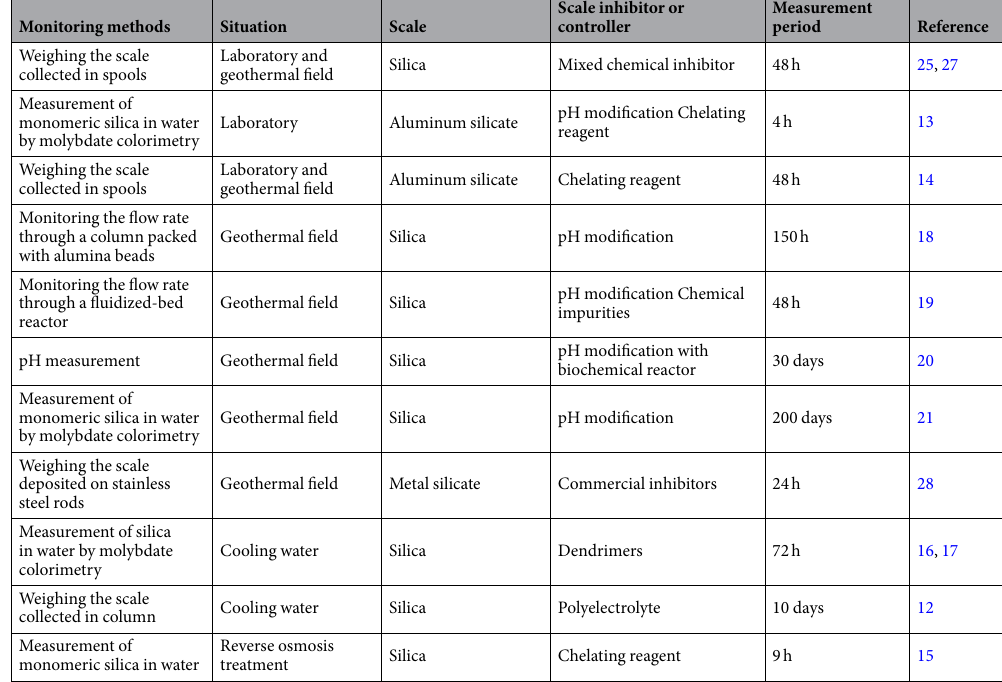
Table 1. Examples of methods of monitoring silica scale formation in the literature on scale prevention or